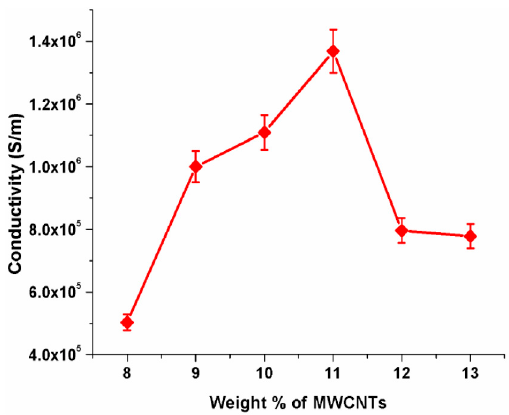
Figure 7. Electrical conductivity change by MWCNT content [150]. Reprinted from the MDPI Sensors, Vol 16, Matta Durga Prakash, Siva Rama Krishna Vanjari, Chandra Shekhar Sharma, and Shiv